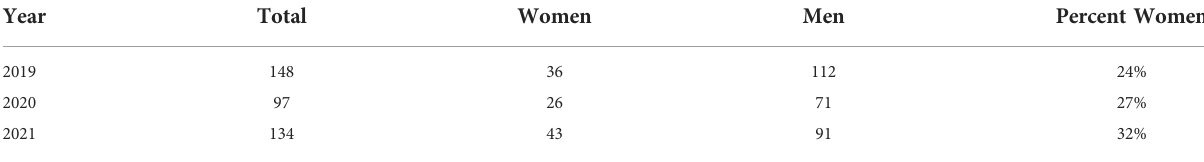
TABLE 2 Gender breakdown of community wildlife scouts trained in